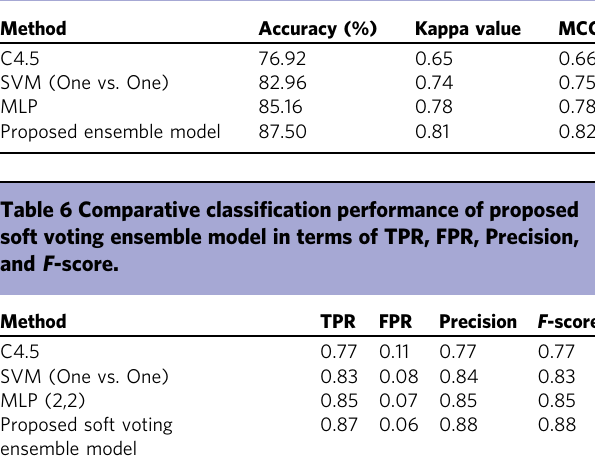
Table 5 Comparative classi fi cation performance of proposed soft voting ensemble model in terms of accuracy, Kappa, and MCC over 10-fold CV.